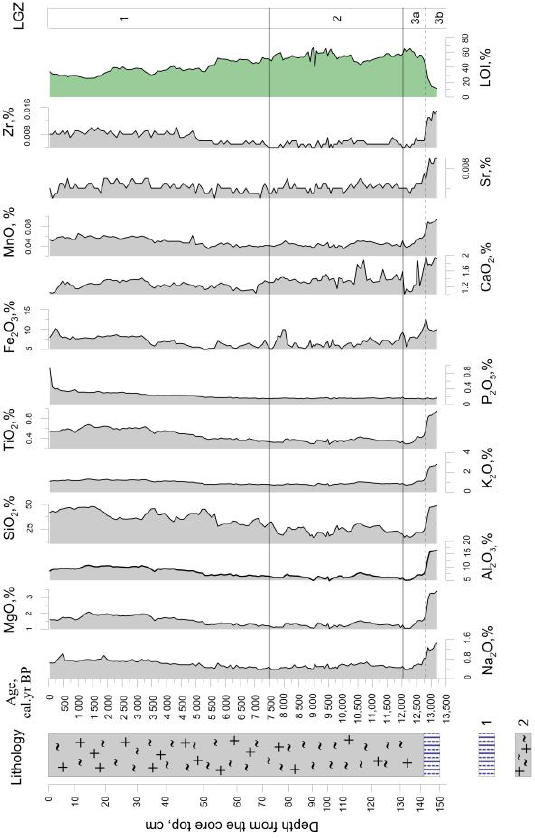
Figure 3. Core lithology and variations in major elements and some trace elements and LOI content in the Lake Kaskadnoe-1 sediments. Following the geochemical analysis, the percentages of 2 microelements and 10 oxides of each of the 150 samples were estimated. Three local geochemical zones (LGZ 1–3) with differing percentages of elements and oxides were identified. The CONISS program [34] for stratigraphically constrained cluster analysis by the method of incremental sum of squares was used to draw LGZ boundaries. Symbols for lithological description: 1 — gray dense clay; 2 — dark-olive biogenic-terrigenous silt with different proportions of diatom valves.